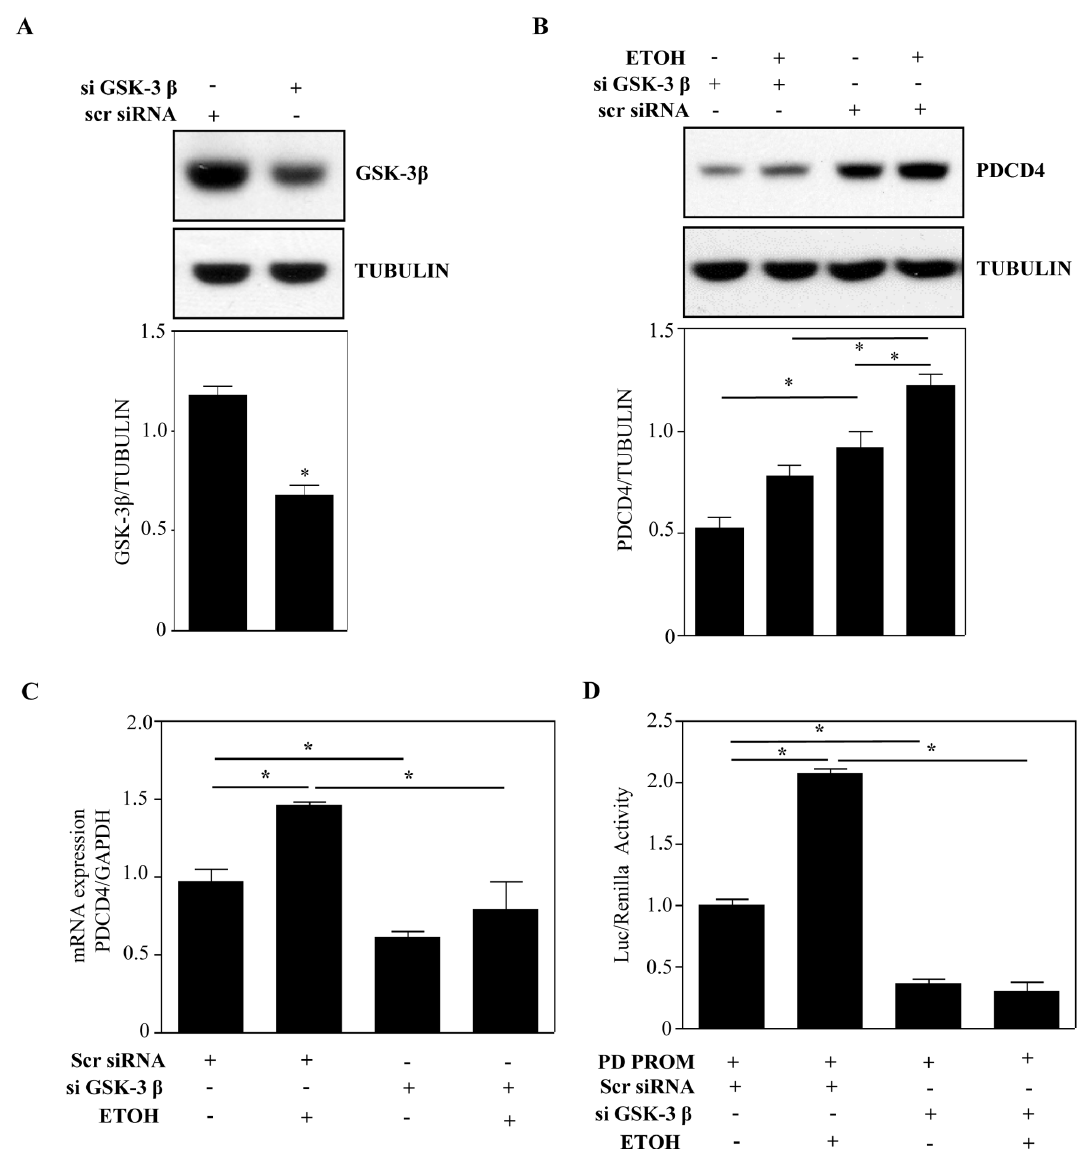
Figure 7. Downregulation of GSK-3 b blocks basal as well as ETOH-induced PDCD4 expression. ( A ) Cells were transfected with 100 nM siRNA against GSK-3 b (si GSK-3 b ) or 100 nM of scramble siRNA (scr siRNA). 24 h post-transfection cell lysates were immunoblotted with anti-GSK-3 b and tubulin. Lower panel shows densitometric scanning of GSK-3 b normalized to tubulin. ( B ) Western analysis of PDCD4 on cell lysates transfected with si GSK-3 b (100 nM) followed by ETOH treatment for 24 h (top panel). PDCD4 and tubulin specific signals were measured by densitometry and the ratios of PDCD4 over tubulin were plotted (bottom panel). *p , 0.05 shows statistical significance using one-way ANOVA following Newman-Keuls posthoc test. ( C ) Quantitative q-RT PCR analysis for PDCD4 transcript expression. Data is expressed as fold change relative to control. ANOVA was performed and *indicate statistical significance at p , 0.05 ( D ) 24 h post-transfection of respective siRNAs (as in Panel A), pGL4.16 or PD PROM luc contructs were transfected. 24 h after transfection cells were treated with or without ETOH for additional 24 h and cell lysates were subjected for dual luciferase assay. Results are expressed as fold change relative to control and data analyzed by ANOVA and Newman-Keul’s posthoc test. *denotes p , 0.05. n=3. neurogenesis, synaptogenesis, cell polarity, neuronal migration, conservancy of PDCD4 regulation among different species (rat axon growth, neuronal plasticity, which has also been pertinent and human) along with developmental stages of neuronal lineage with ethanol insult (reviewed in [34,35,76,77]. Though a positive (neuro-precursor mitotic neuroblasts and differentiated neurons) role for GSK-3 b involvement in PDCD4 protein regulation has (Figure S6 & Figure S7). GSK-3 b is a key constituent of canonical been recently reported in lung cancer cells [78], our studies Wnt/ b -catenin signaling pathway in vertebrates and wingless provide the first evidence for transcriptional regulation of PDCD4 signaling pathway in Drosophila and is long known to play by GSK-3 b in a developmental neuronal setting. Furthermore, significant role in embryonic brain development (reviewed in our results point to an abnormal expression of PDCD4 induced by [74,75]). Alterations in GSK-3 b activity produces abnormalities in